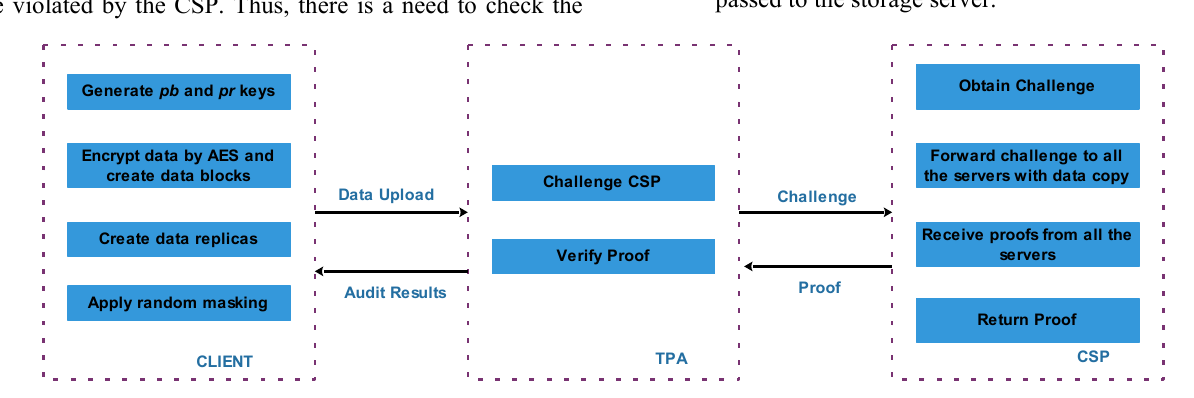
Figure 1 . Overall flow of the OA-DIV